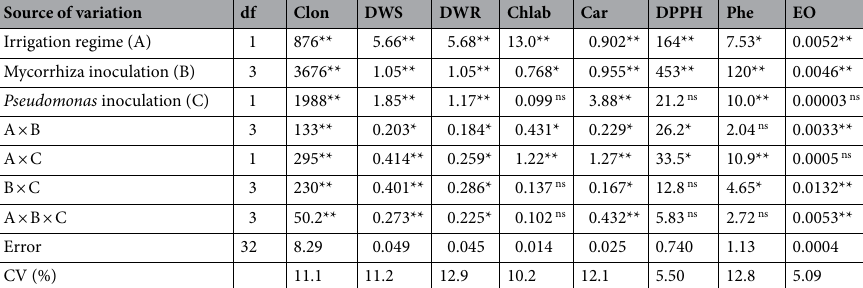
was used to detect specific differences. That the results of the mean comparison were only presented for the traits with statistically significant effects of experimental factors. ANOVA was performed using SAS software (SAS Institute, Cary, NC, USA, 1990). Principal component analysis (PCA) was used to reduce the number of vari- ables measured on Arizona cypress and to measure multivariate co-linearity among the traits and items which was performed using StatGraphics (ver. 9).